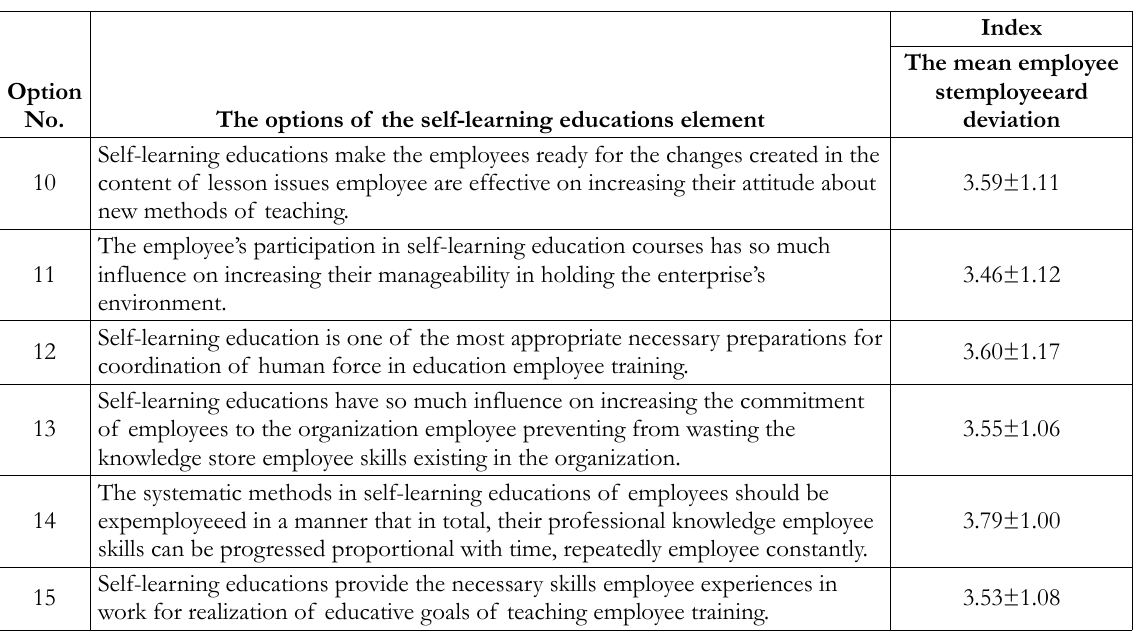
Table 3. The mean employee stemployeeard deviation of options of self-learning educations element The Pearson correlation between the elements of